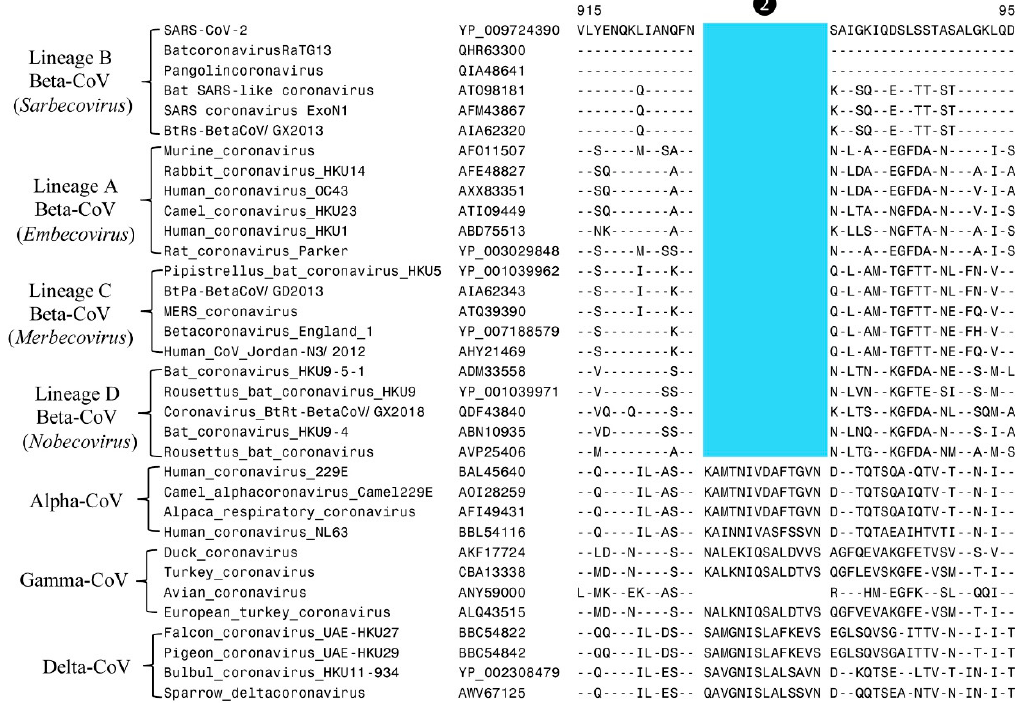
Figure 2 . Partial sequence alignments of two conserved regions from the spike protein showing two different CSIs that are specific for the genus Betacoronavirus . The CSIs present in these sequence alignments are highlighted in blue and they are labeled ❶ and ❷ . Both CSIs are commonly shared by all members of the genus Betacoronavirus , but barring one exception, avian coronavirus, they are not found in any other CoV. Dashes (–) in these and all other sequence alignments denote identity with the amino acid shown in the top sequence. The numbers on the top indicate the locations of these sequence regions within the indicated proteins. The accession numbers of different proteins are given in the second column.